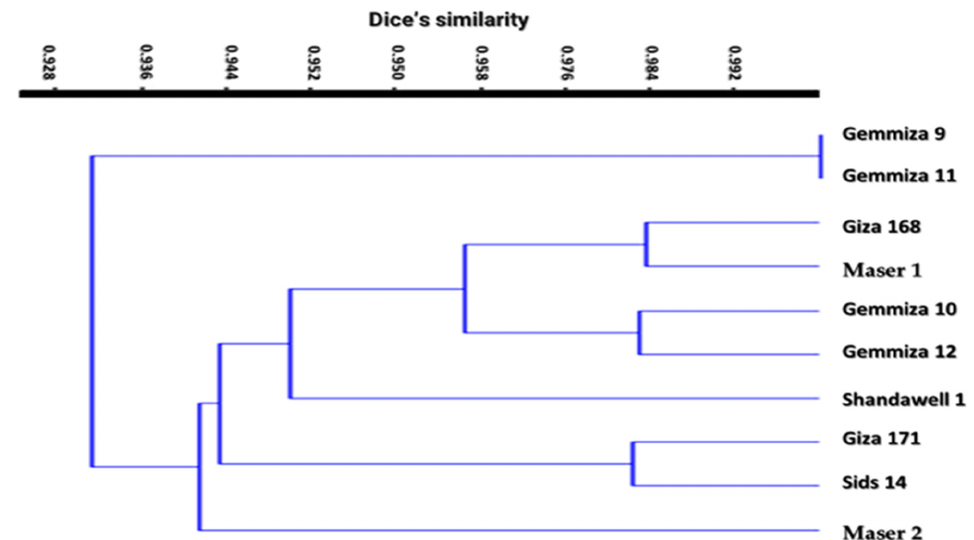
Figure 1. Dendrogram of ten wheat cultivars constructed using SCoT data analysis depending on Dice coefficient and UPGMA method. On the other hand, the binary scoring achieved by SCoT analysis was used to cal- culate Jaccard’s similarity matrices (Supplementary Materials Table S1). Based on five